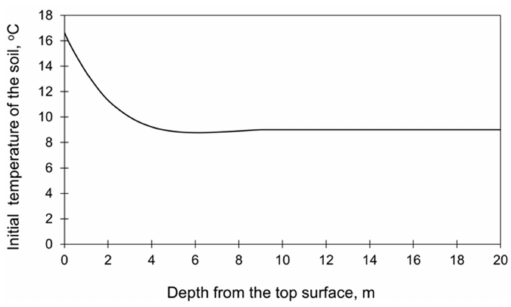
Figure 5. The initial temperature of the subsoil